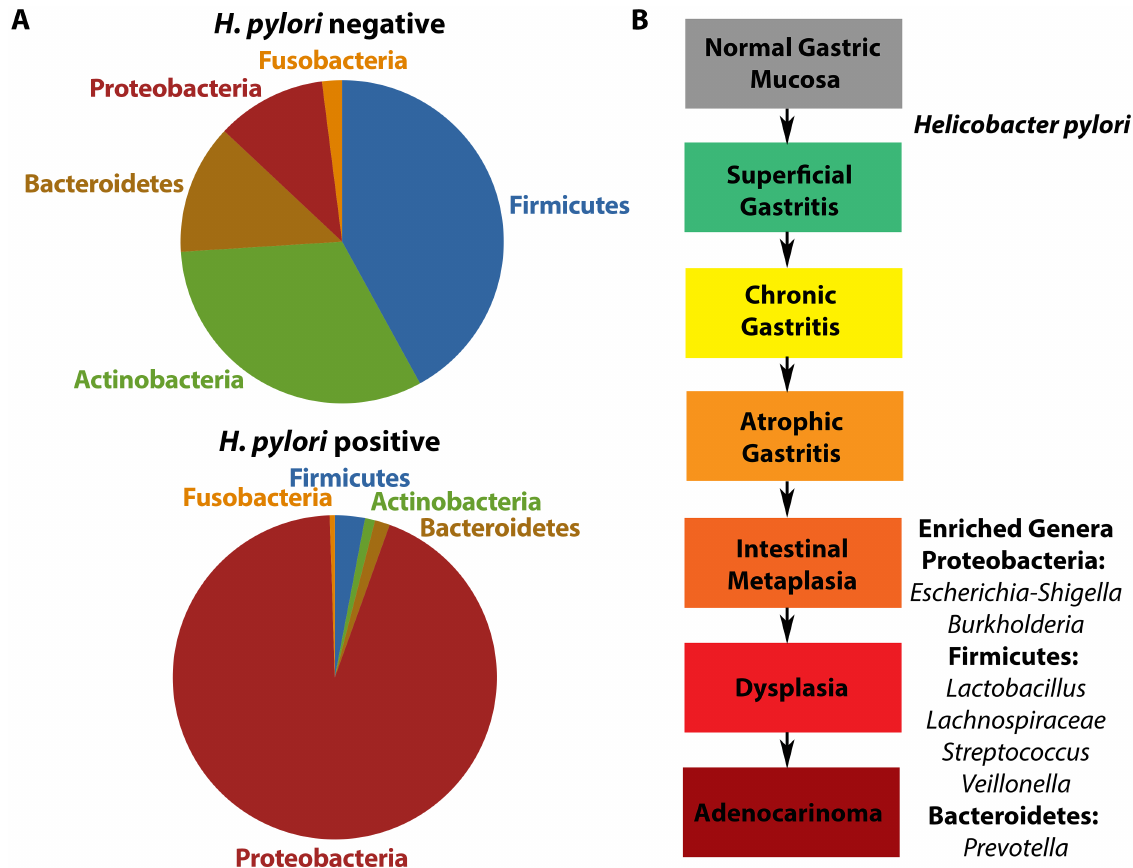
Fig 1. Alterations in the gastric microbiota following Helicobacter pylori infection and gastric disease progression. (A) Schematic representation of the predominant phyla of the gastric microbiotabased on H . pylori infectionstatus. H . pylori -negative individualsharbor a microbiotathat is more complex and highlydiverse comparedto H . pylori -positive individuals. (B) Schematic representation of the predominantgeneraat different stages within the gastric carcinogenesis cascade. Followinginfectionwith H . pylori , Proteobacteria and specifically H . pylori dominatethe gastric microbiota. This leads to the development of chronicgastritis. In the later stages of the disease,rangingfrom intestinal metaplasiato gastric adenocarcinoma, a number of generaare enriched. These include Escherichia-Shigella and Burkholderia within the Proteobacteria phylum; Lactobacillus , Lachnospiraceae , Streptococcus , and Veillonella within the Firmicutes phylum; and Prevotella within the Bacteroidetes phylum.